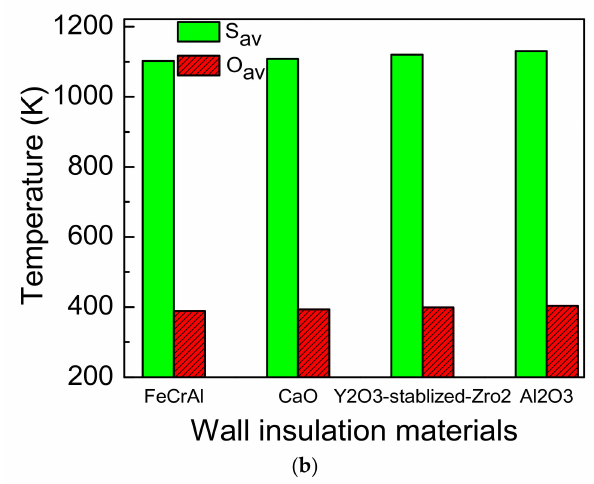
Figure 12. The temperature distribution at 150 kW / m 2 , 1 atm, 1.8 L / h and 0.7 emissivity: ( a ) Temperature distribution along the axial length of di ff erent wall insulation materials and ( b ) the surface average (S av ) and outlet average (O av ) temperatures of di ff erent wall insulation